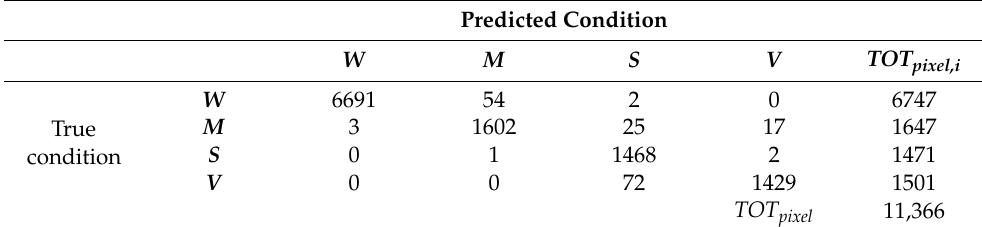
Table 5. Confusion matrix between predicted S2 classification and ground